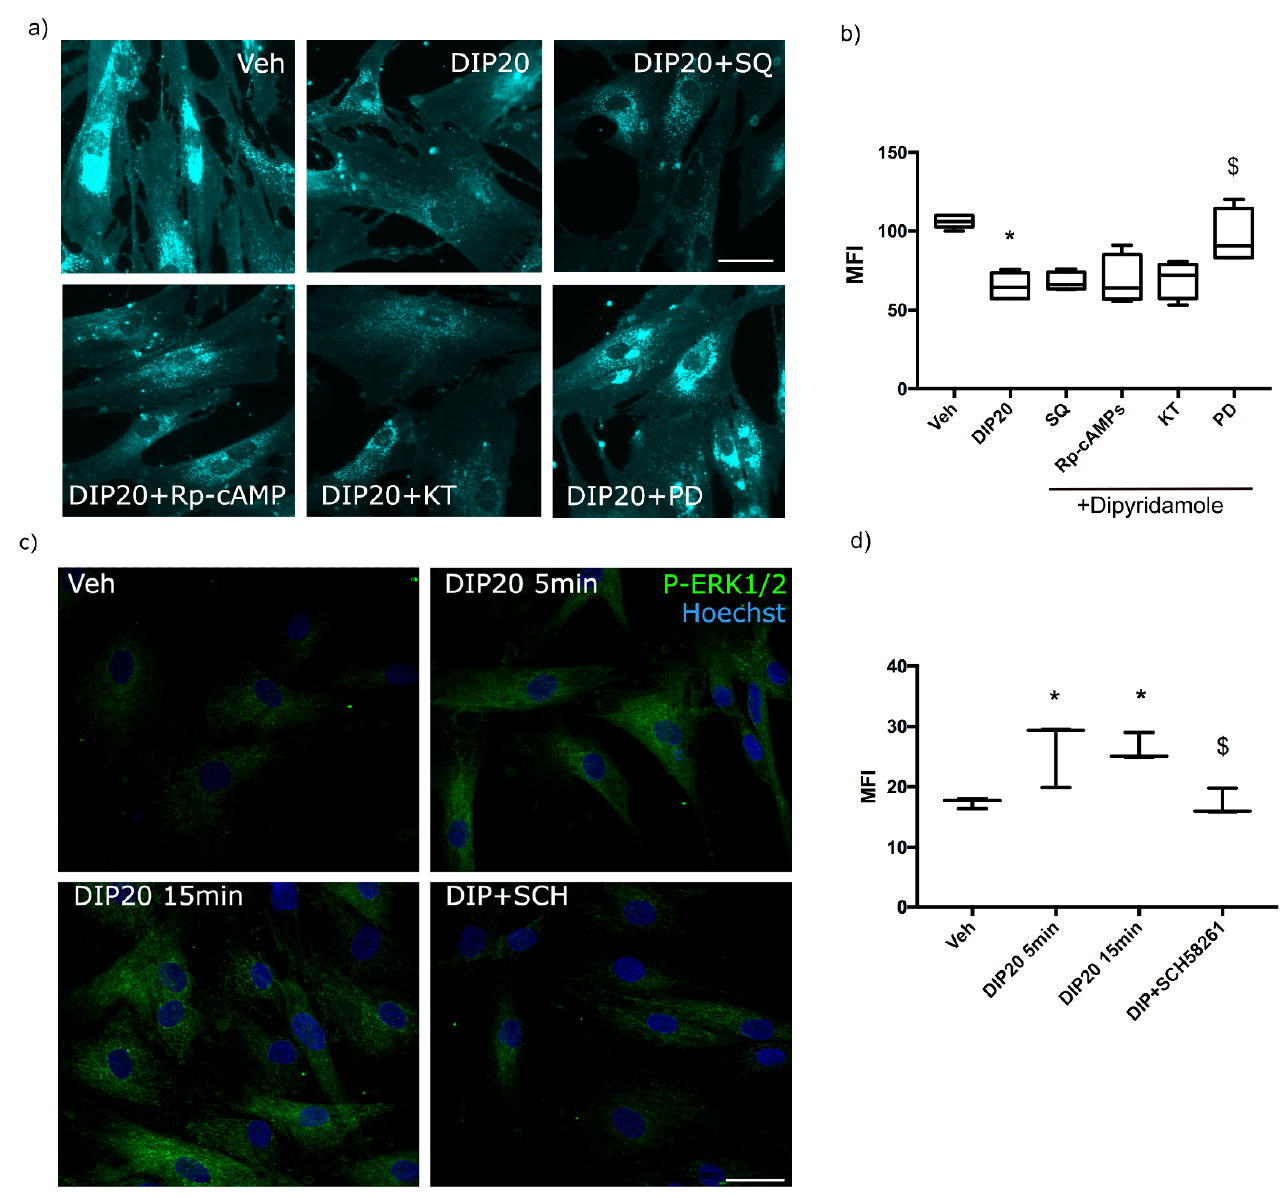
Figure 4. Effect of inhibitors of A 2A R-dependent pathways on the ability of dipyridamole to reduce cholesterol accumulation. ( a ) Representative images of Filipin III-stained NPC1 fibroblasts (GM17911) treated with 20 μ M of dipyridamole (DIP20) alone or in combination with an adenylate cyclase inhibitor (100 μ M SQ22536), an inhibitor of cAMP-dependent activation of PKA (200 μ M Rp-cAMPs), an inhibitor of PKA (10 μ M KT5720) and an inhibitor of MEK1 (50 μ M PD98059). ( b ) Quantification of mean fluorescence intensity (MFI) of Filipin III staining, expressed as a percentage of veh-treated cells. The MEK1 inhibitor PD98059 blocked the effect of DIP20 on cholesterol accumulation. ( c ) Representative images of P-ERK1/2 and Hoechst-stained NPC1 fibroblasts (GM17911) treated for 5 and 15 min with 20 μ M of dipyridamole (DIP20 5 min; DIP20 15 min) alone or in combination with the A 2A R antagonist SCH58261 (10 μ M). ( d ) Quantification of mean fluorescence intensity (MFI) of P-ERK1/2 staining. * p < 0.05 vs. veh-treated; $ p < 0.05 vs. DIP20-treated cells after one-way ANOVA ( n = 3–5 independent experiments). Data are expressed as box-plots (whiskers from min to max values). Scale bars = 20 µm.